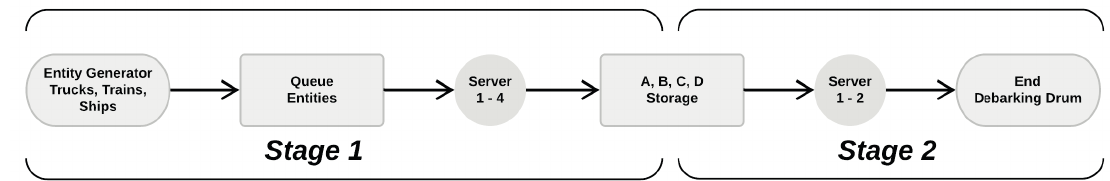
Figure 2. A general model 1 system layout of log-yard logistics at a pulp